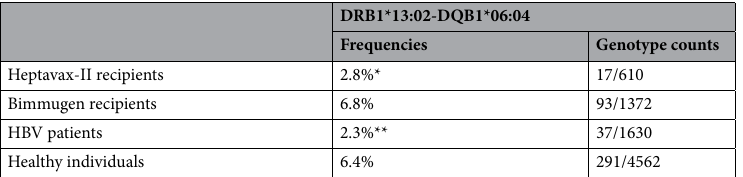
Table 3. Haplotype frequencies and genotype counts in Japanese vaccines (high-responders), Japanese chronic hepatitis B patients, and healthy Japanese individuals. *Significant association was identified in comparison with healthy Japanese individuals (OR = 0.34, P = 4.30 × 10 −4 ). **Significant association was identified in comparison with healthy Japanese individuals (OR = 0.42, P = 2.05 × 10 −10